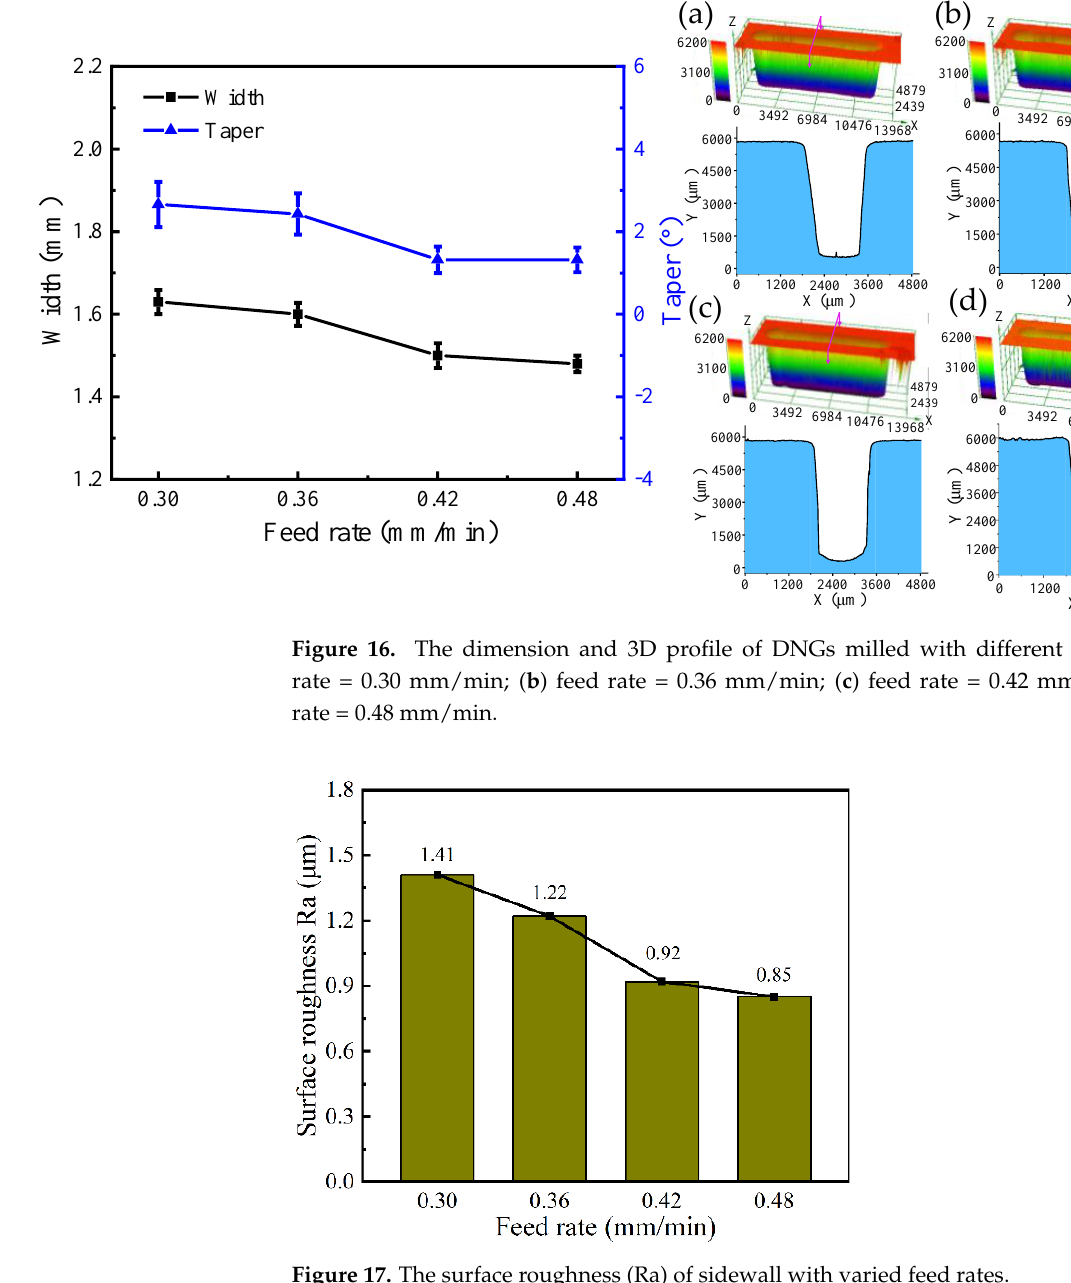
Based on the above research, the complex deep-narrow groove structures with ma- chining depth of 5 mm are machined on GH4169 nickel-based alloy in one-pass feed by using a wedged end face tube electrode with wedged angle of 40 ◦ , as shown in Figure 18. The machining parameters are a feed rate of 0.48 mm/min, applied voltage of 25 V, spindle speed of 4000 rpm, pulse frequency of 1 kHz, and pulse duty of